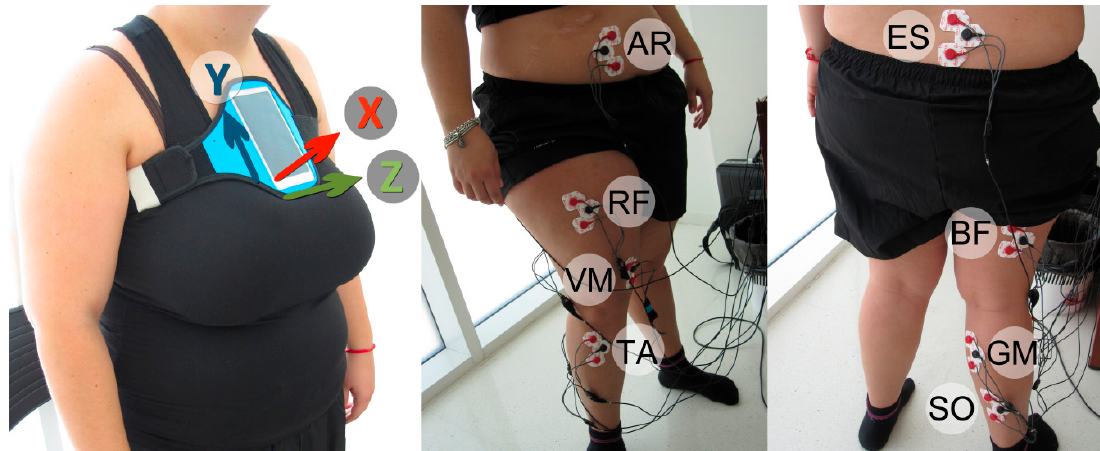
Figure 1. X, Y and Z axes and their direction from a Smartphone placed in Sternum ( left ) and EMG sensor placement ( middle and right ) in gastrocnemius medialis (GM), the biceps femoris (BF), the vastus medialis of the quadriceps (VM), the abdominal rectus (AR), the erector spinae (ES), the rectus femoris (RF), the soleus (SO), and the tibialis anterior (TA).